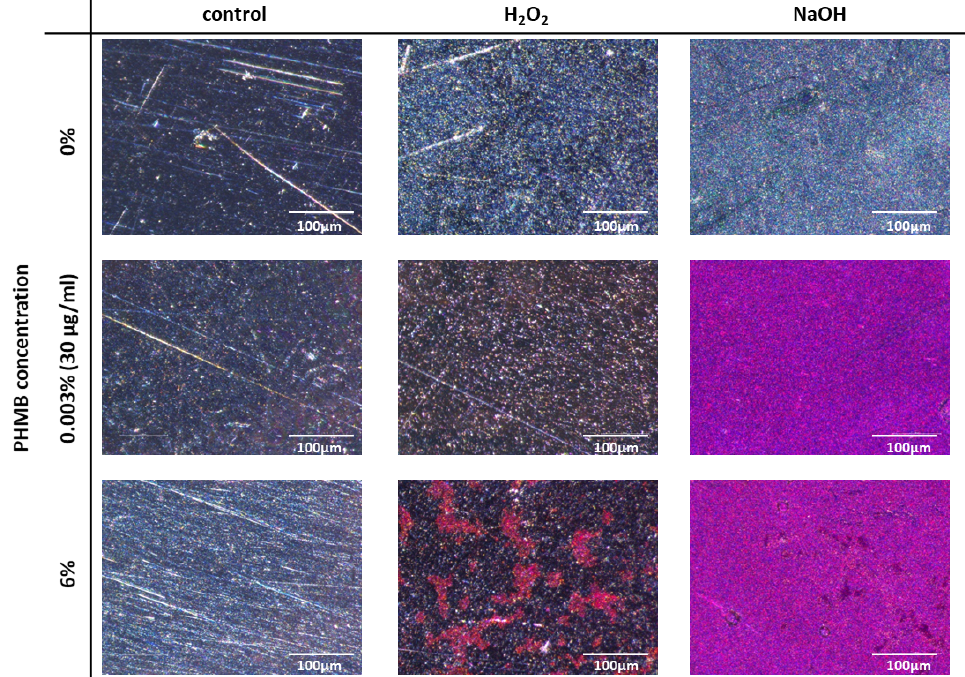
Figure 7. PHMB stained with Rose Bengal after treatment of the test specimen with NaOH and H 2 O 2 following coating with PHMB in 30 µ g/mL (0.003%) or 6% PHMB solution. Staining of the adsorbed PHMB was possible on NaOH pre-treated surfaces. The treatment with H 2 O 2 following PHMB adsorption (30 µ g/mL) did not result in a visible staining. Treatment with 6% PHMB enabled a staining of single islands of